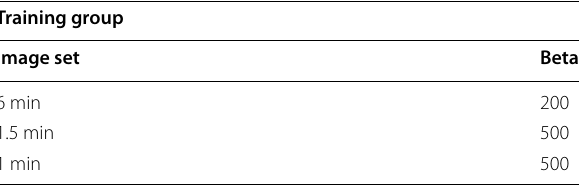
Two CNNs were trained using subset pairs, one consisting of 6 min and 1.5 min and the other was 6 min and 1 min